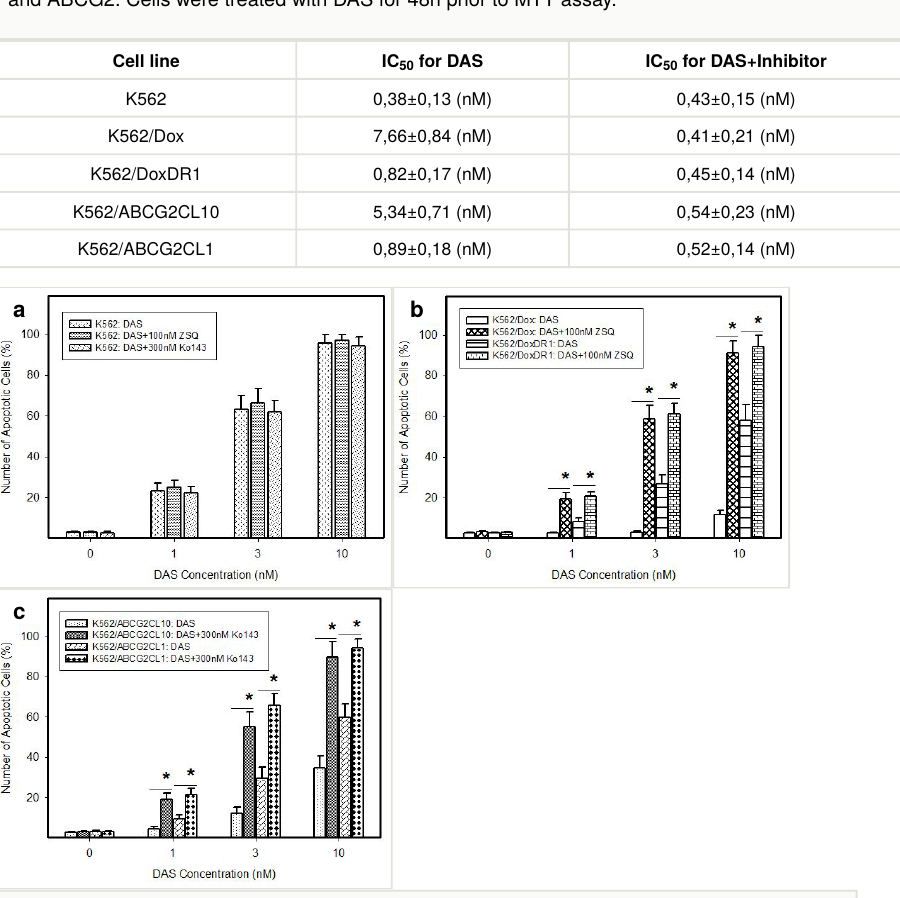
Figure 3. Pro-apoptotic e ff ects of DAS in cells expressing ABCB1 or ABCG2. Cells were treated